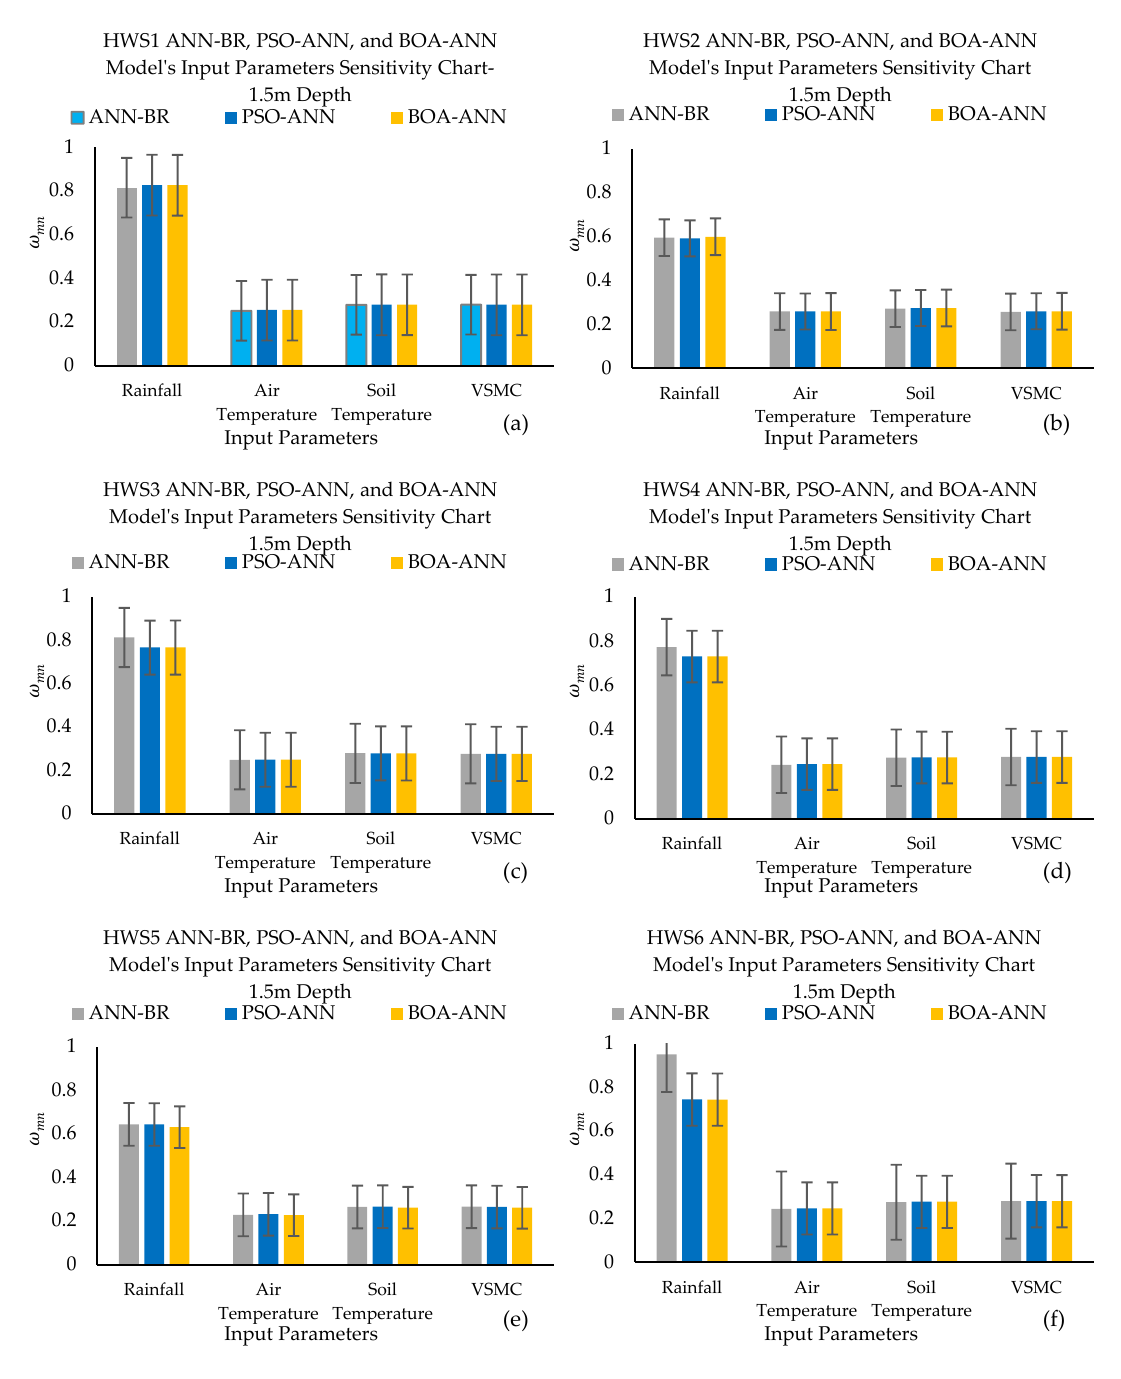
Figure 12. The sensitivity factor of input parameters on the predicted output for the ANN-BR, PSO-ANN, and BOA-ANN at 1.5 m depth ( a ) HWS 1 ( b ) HWS 2 ( c ) HWS 3 ( d ) HWS 4 ( e ) HWS 5 ( f ) HWS 6.